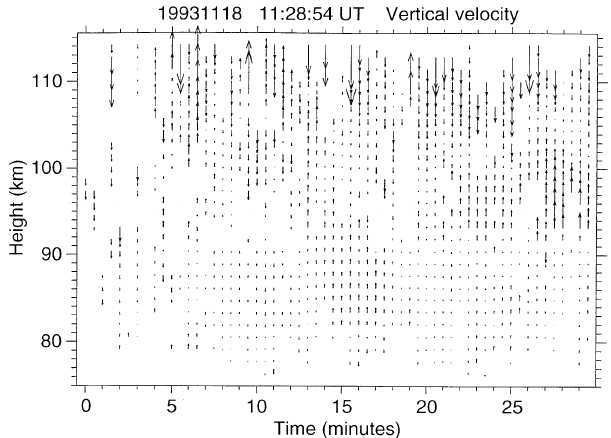
Fig. 5. Vector plot of vertical velocities derived from the rate of change of phase as illustrated in Fig. 4, 18 November, 1993, 1129 — 1200 UT. There are clearly coherent regions of both upwards and downwards velocity evident. The distance between vectors cor- responds to 10 ms